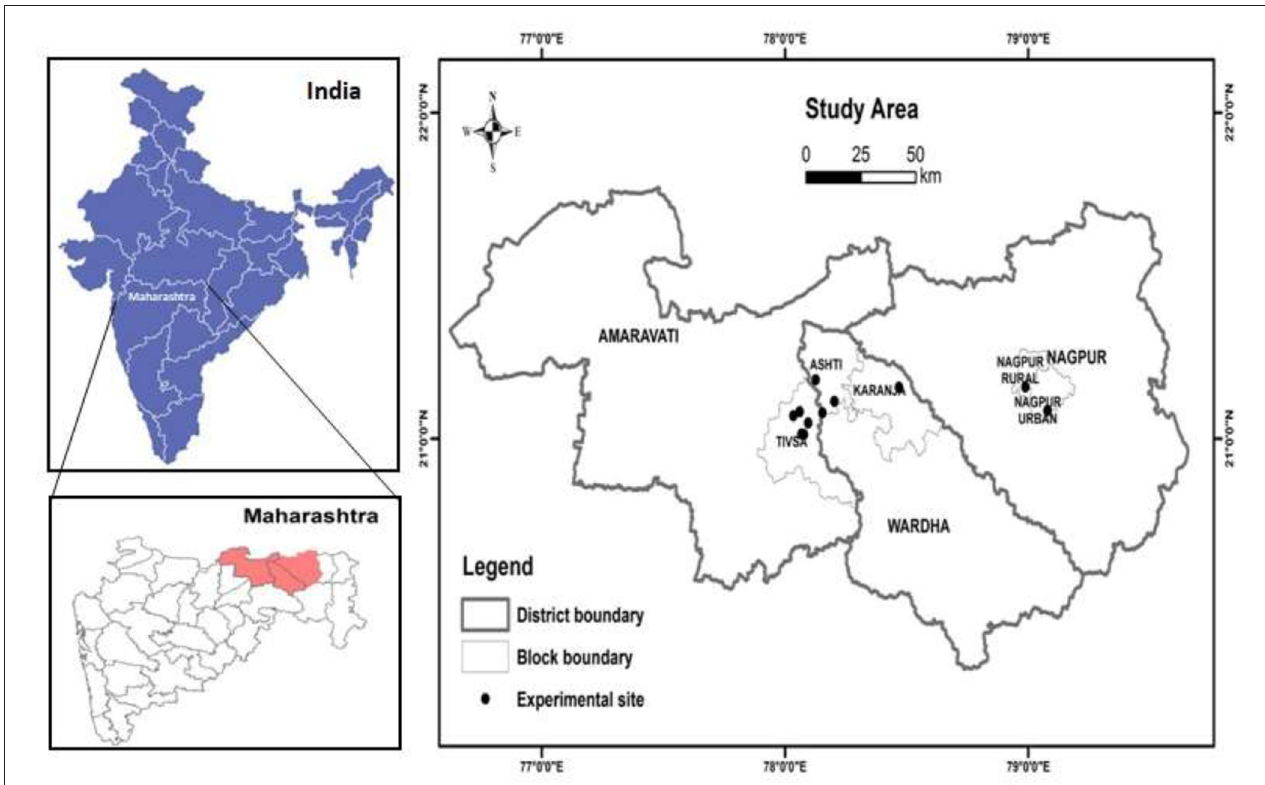
FIGURE 1 | Location map of the study area.